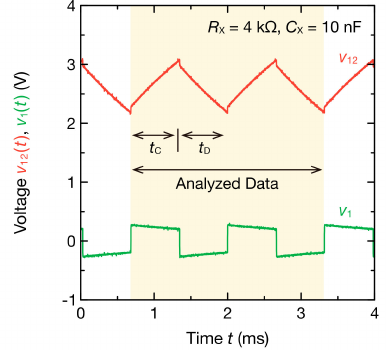
Figure 3. Example of the oscillation waveforms of v 12 ( t ) and v 1 ( t ) measured in the circuit of Figure 2b. The R X and C X were set to 4.0 k Ω and 10 nF, respectively. The segment of time with a colored background corresponds to two cycles of the oscillation and was used for the subsequent discrete Fourier transform (DFT) analysis.